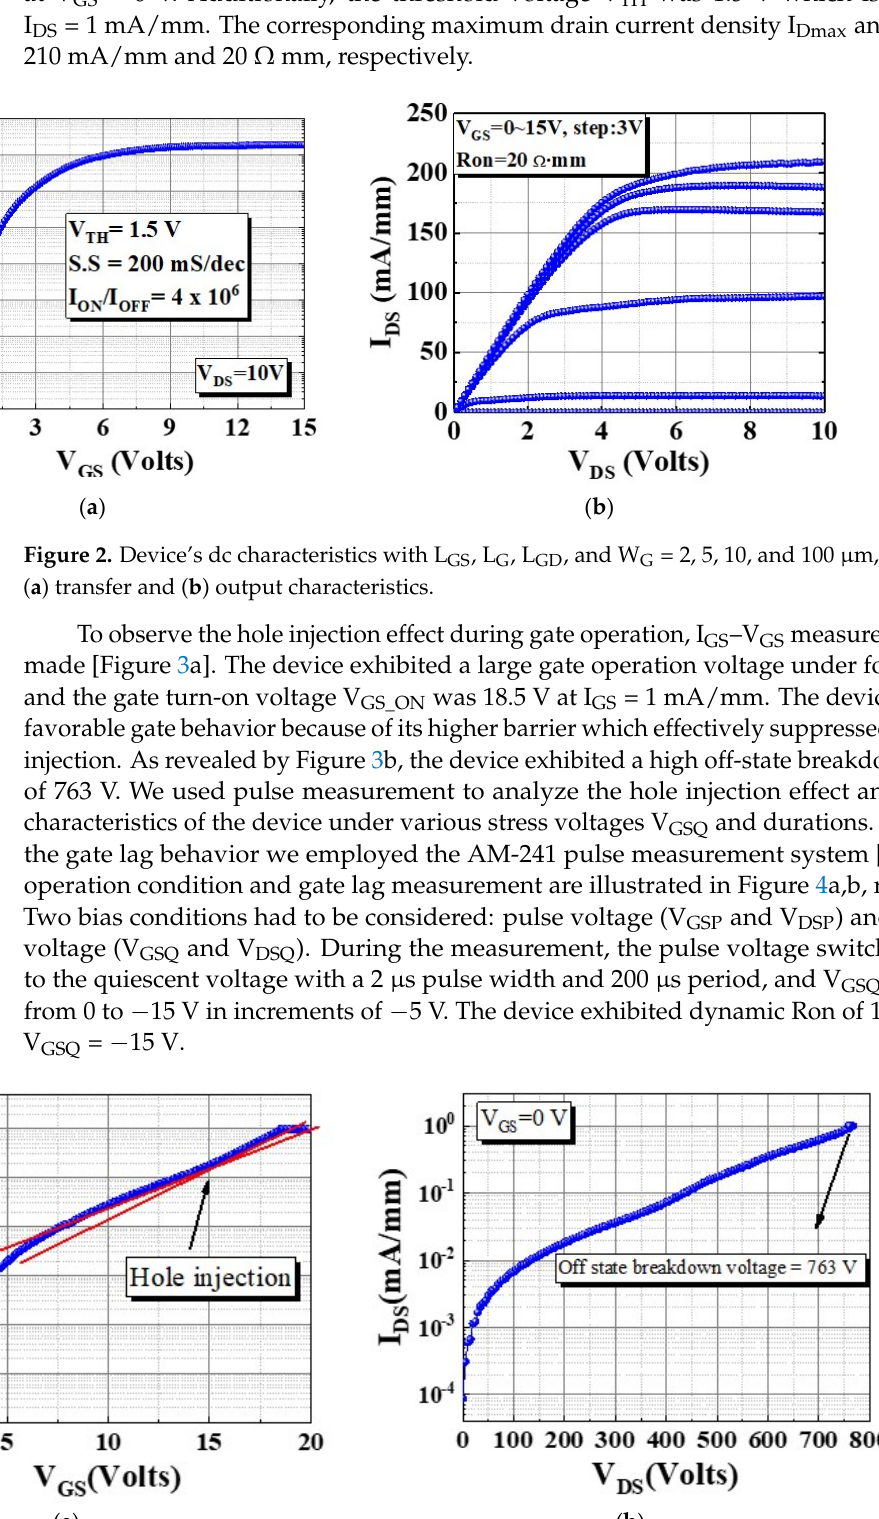
( b ) Figure 4. ( a ) Condition of pulse measurement and ( b ) gate lag characteristic. ( a ) ( b ) Figure 5. ( a ) Dynamic transfer characteristics measured for various stress durations, and ( b ) V TH shifting for different V GSQ .